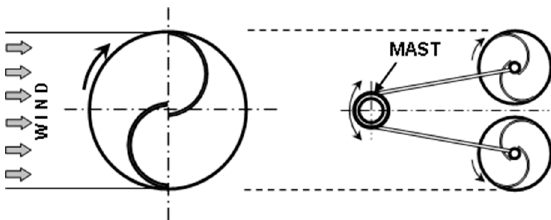
Figure 6. Substitution of the Savonius rotor by a system of twin rotors and shielding plates.